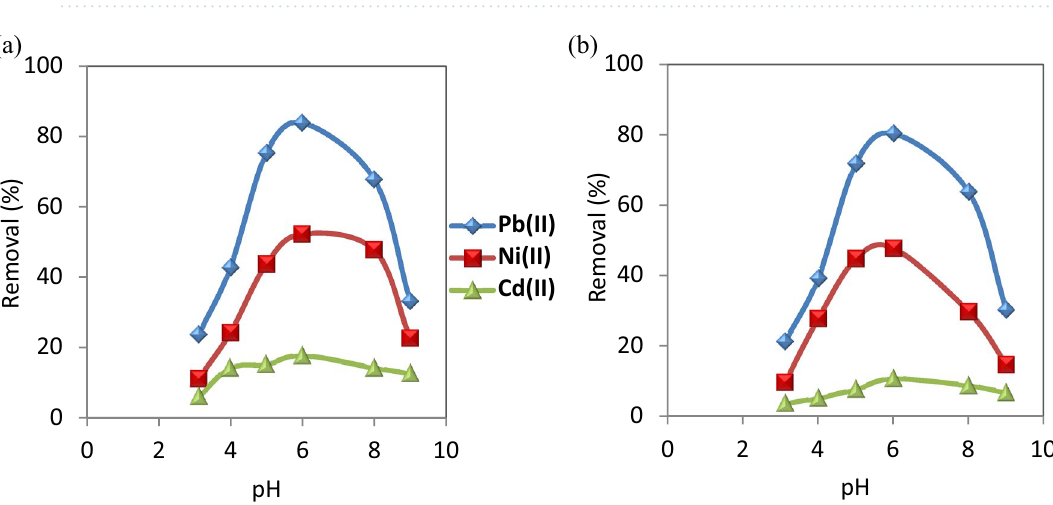
Figure 6. Effect of pH on the removal of the studied metal ions using ( a ) CuO NPs-1 and ( b ) CuO NPs-2 at initial concentration: 20 mg L −1 , contact time: 60 min, pH: 6, and dose: 0.33 g L −1